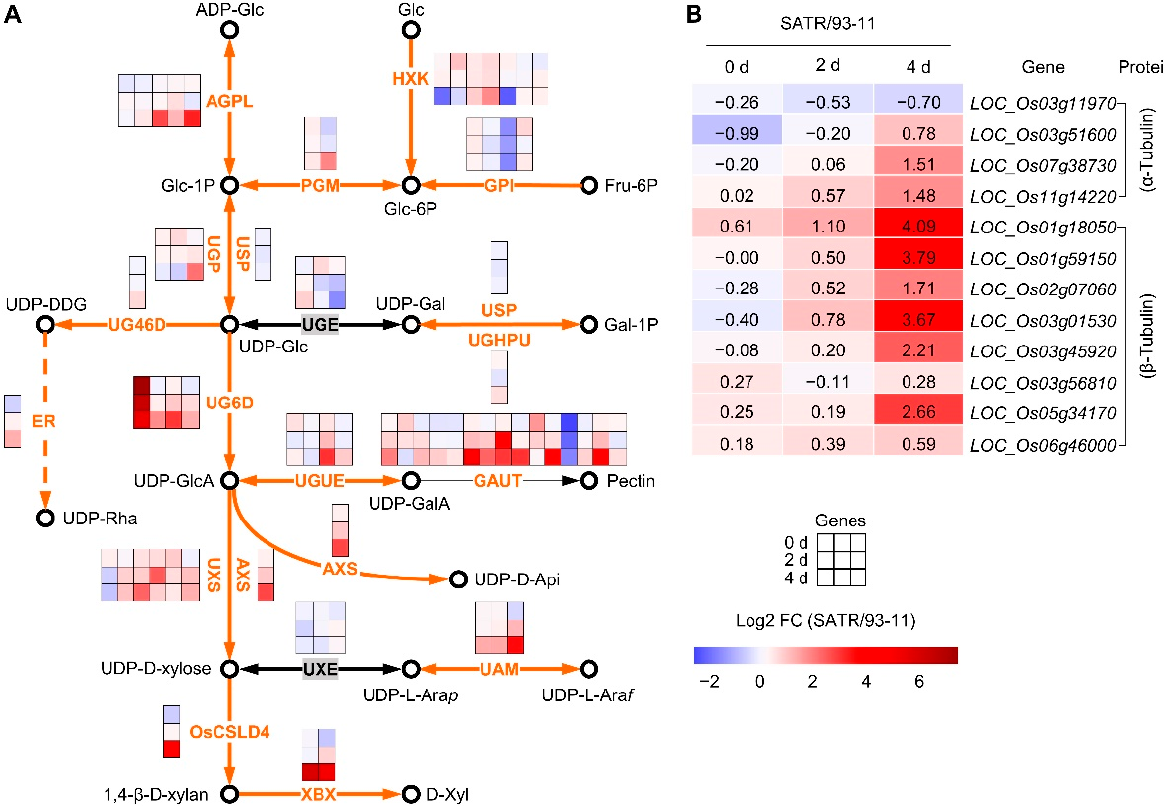
Figure 2. Expression analysis of hemicellulose and pectin biosynthesis pathway genes ( A ) and tubulin genes ( B ) between SATR and 93-11 under SSAS. The solid and dotted arrows indicate the direction of directly and indirectly enzyme-catalyzed reaction, respectively. The single-headed and double-headed arrows indicate irreversible and reversible reactions, respectively. The open circle indicates metabolite (substrate or product of enzyme reaction). The black symbol beside the metabolite indicates name of the corresponding metabolite. The orange name between two metabolites represents a group of enzymes involved in this reaction. The names of enzymes or metabolites were indicated with acronym. The color of small inner cell in the first, second and third row of the big composite box beside the enzyme corresponds to the value of log2 fold change (SATR/93-11) of the corresponding encoding gene between SATR and 93-11 seedling samples under SSAS for 0 days, 2 days and 4 days, respectively. The orange arrows indicate the overall increased gene expressions of the encoding enzymes which catalyze the corresponding step of enzyme-catalyzed reaction in SATR compared with 93-11 (SATR/93-11) under SSAS. The detailed information of these enzyme-encoding genes and full names of the metabolites were summarized in Table S3, respectively. The thresholds for DEGs are |log2 [fold change (SATR/93-11)]| > 0.5850 (1.5-fold change value of gene expressions in